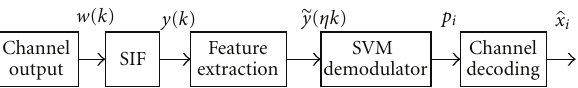
Figure 1: The block diagram of EBPSK